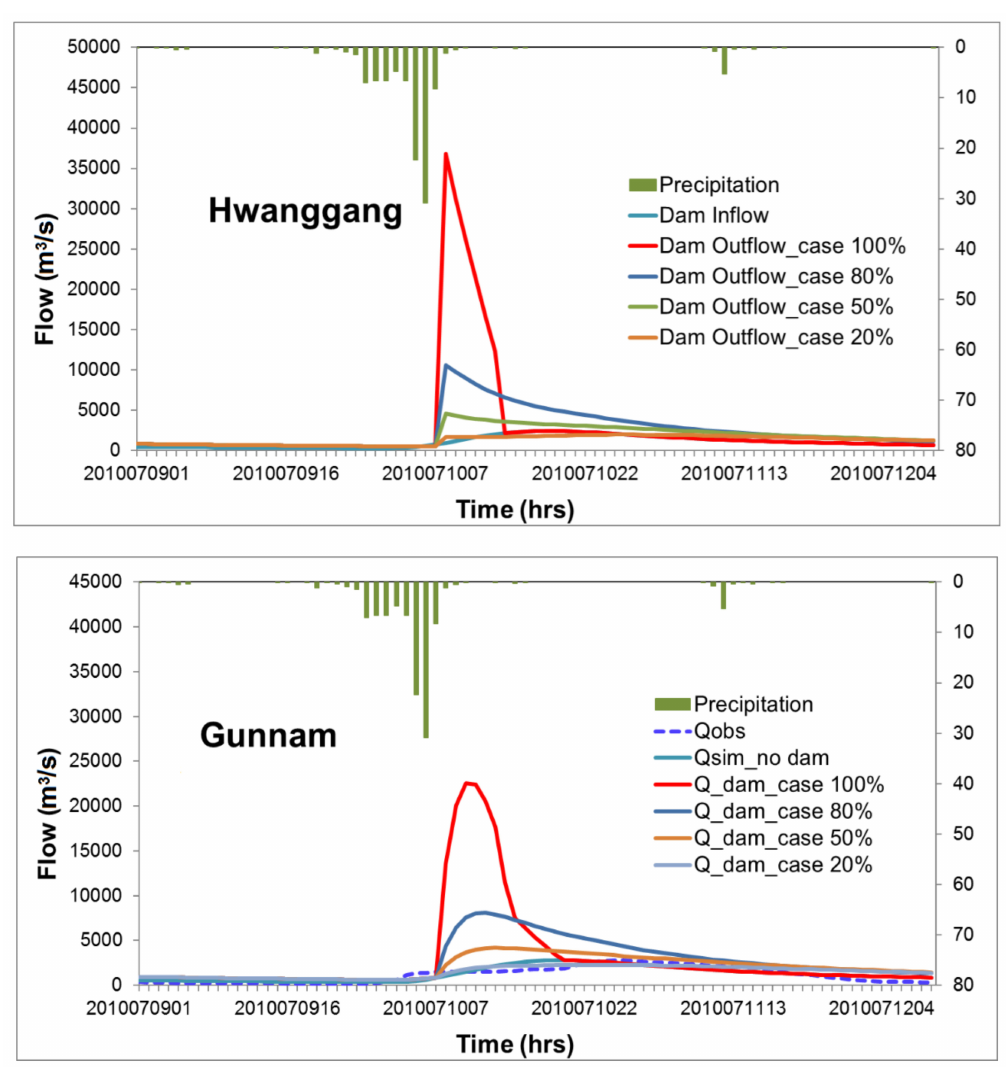
Figure 5. Simulated outflow at Hwanggang dam ( upper ) and Simulated discharge at Gunnam station ( lower ) in 4 dam failure